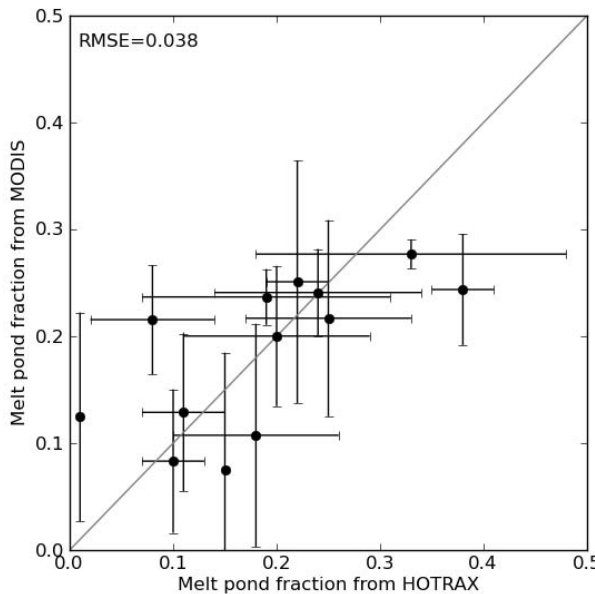
Fig. 11. Values from the MODIS melt pond product plotted versus NSIDC melt pond statistics for the years 2000 and 2001 and the three sites (i) Beaufort Sea, (ii) North of the Canadian Archipelago, (iii) and Fram Strait. The error bars are the standard deviation of the gridding from the results to 10 × 10 km 2 for NSIDC data and to 12.5 × 12.5 km 2 for the MODIS data. The RMSE is 10.7% and the coefficient of determination is R 2 = 0 . 28.